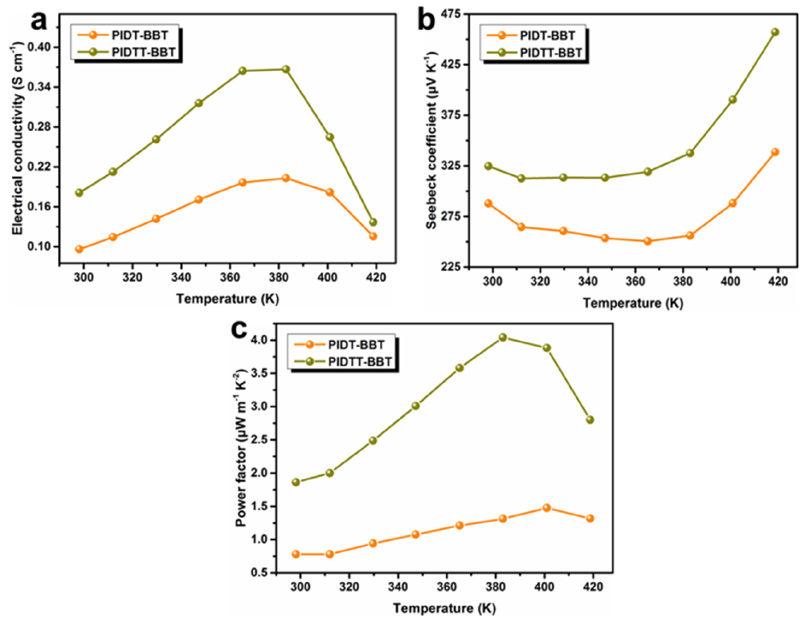
Figure 3. Temperature dependence of ( a ) σ , ( b ) S and ( c ) PF for PIDT-BBT and PIDTT-BBT films doped with F4TCNQ (25 mol%) from 298 K to 418 K.